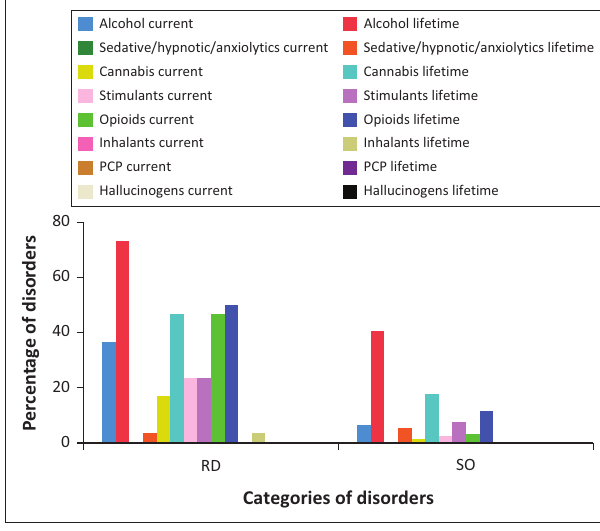
FIGURE 2: Prevalence of alcohol use disorders and substance use disorders among remand detainees and sentenced offenders.